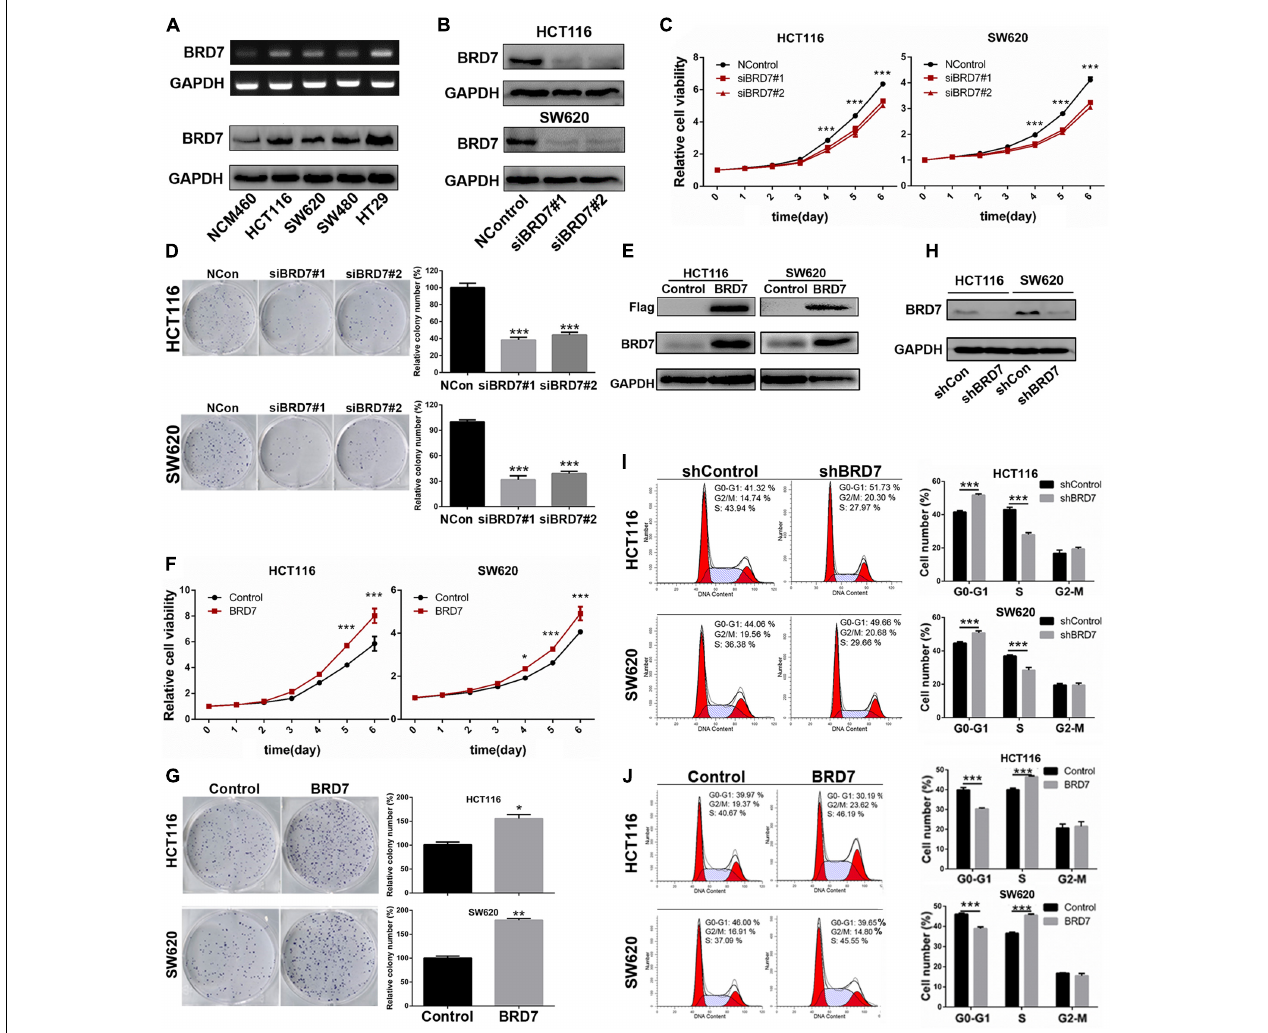
FIGURE 2 | Effect of BRD7 on the cell proliferation and cell cycle of colorectal cancer (CRC) cells. (A) BRD7 mRNA and protein expression levels were detected by RT-PCR and western blotting in HCT116, SW620, SW480, and HT29 CRC cell lines and the normal colon mucosal epithelial cell line NCM460. (B) Western blotting confirmed the interference efficiency of BRD7 siRNAs on endogenous BRD7 protein levels in HCT116 and SW620 cells. (C,F) The effect of BRD7 knockdown and overexpression on cell viability detected by CCK-8 assays. (D,G) The effect of BRD7 knockdown and overexpression on the colony formation of HCT116 and SW620 cells. (E,H) Western blot analysis confirmed the BRD7 protein expression levels in HCT116 and SW620 cells with stable BRD7 overexpressing or knockdown, respectively. (I,J) The effect of BRD7 stable knockdown or overexpression on cell cycle progression, as determined by flow cytometry. The results are presented as the mean ± SD. * P < 0.05, ** P < 0.01, *** P <